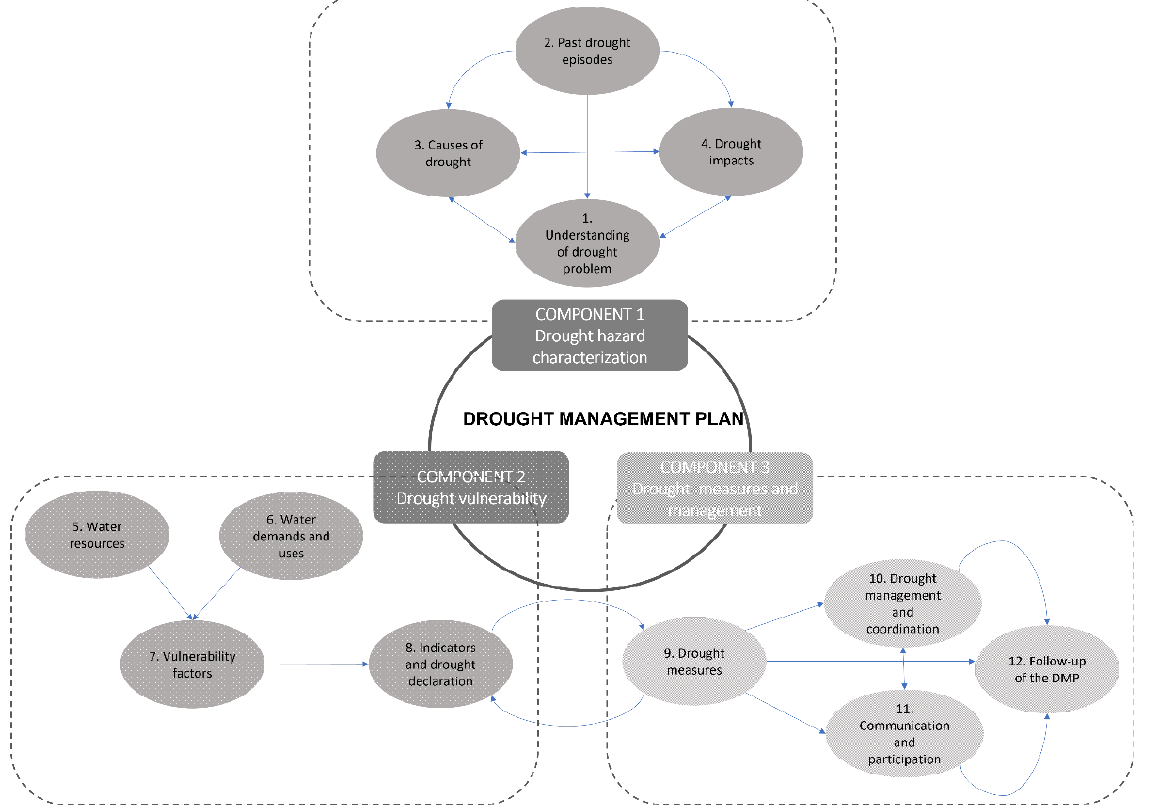
Figure 1. Conceptual framework for the assessment of drought management plans.